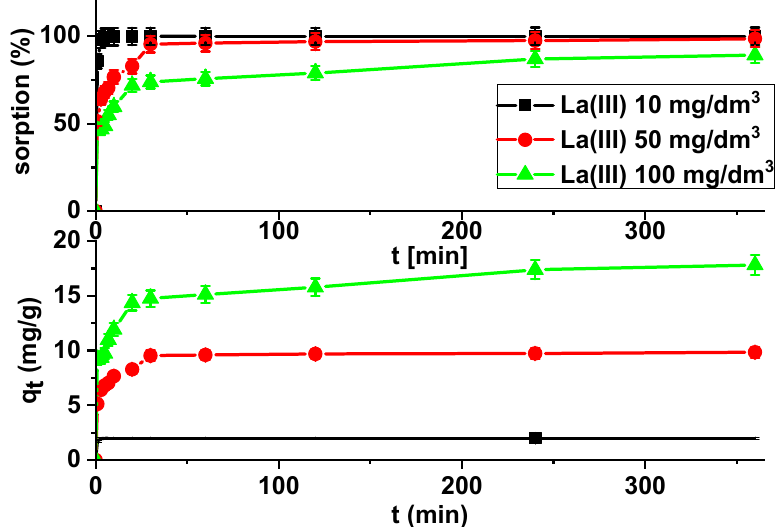
Figure 7. Lanthanum(III) sorption efficiency and sorption capacities as a function of time on X np (c 0 = 10, 50 and 100 mg/dm 3 , pH = 4, shaking speed 180 rpm, temperature 295 K).